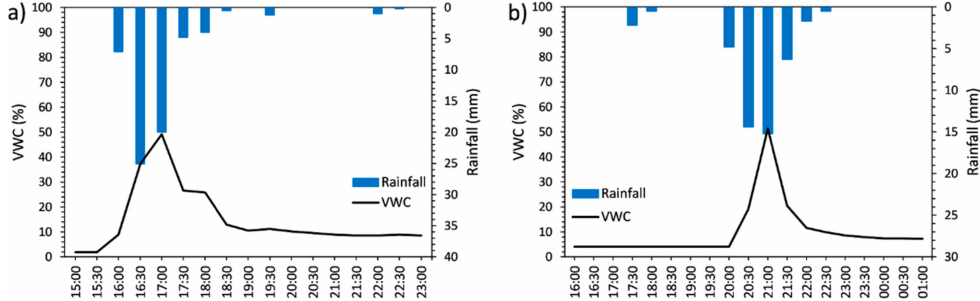
Figure 5. Soil moisture response in micro-catchment 3 as a result of two precipitation events in 2018: ( a ) 26 September 2018 (59 mm); and ( b ) 4 October 2018 (37 mm). The x -axis represents the time of